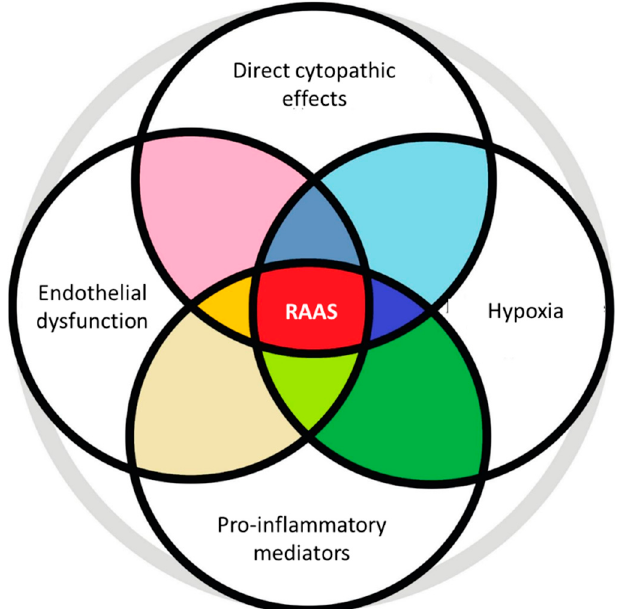
Figure 2. Mutual potentiation of the main pathophysiological mechanisms triggered by SARS-CoV-2 in case of damage to the cardiovascular system.